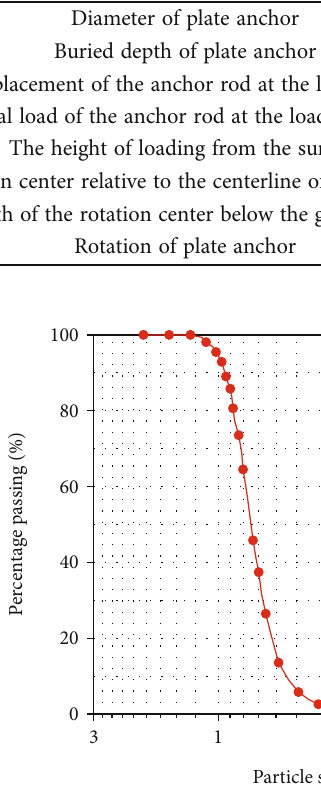
Figure 2: Particle grading curve of the soil